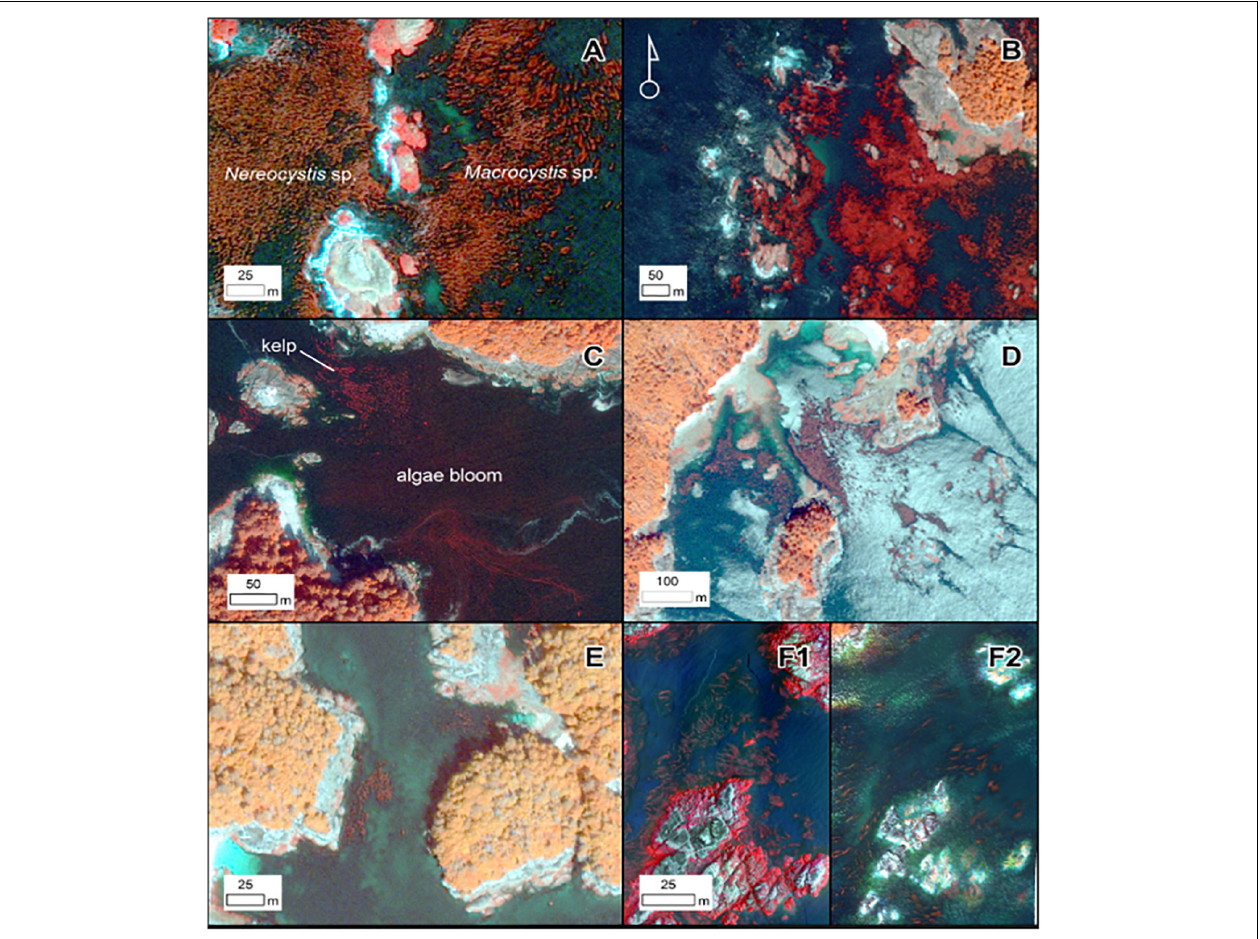
FIGURE 1 | Pansharpened (0.5 m), false-color infrared World View-2 imagery depicting some of the factors described in Table 1 . (A) Both Nereocystis luetkeana and Macrocystis pyrifera canopy are present. (B) Waves present in imagery (white areas on western side of island). (C) Algae bloom and kelp canopy present in the same regions. (D) Specular reflection present in imagery (white areas on water surface), obscuring the kelp bed. (E) Presence of shadow along the shoreline. (F) Drone imagery of the same site at low tide (F1) and high tide (F2) . WorldView-2 and drone imagery provided by the Hakai